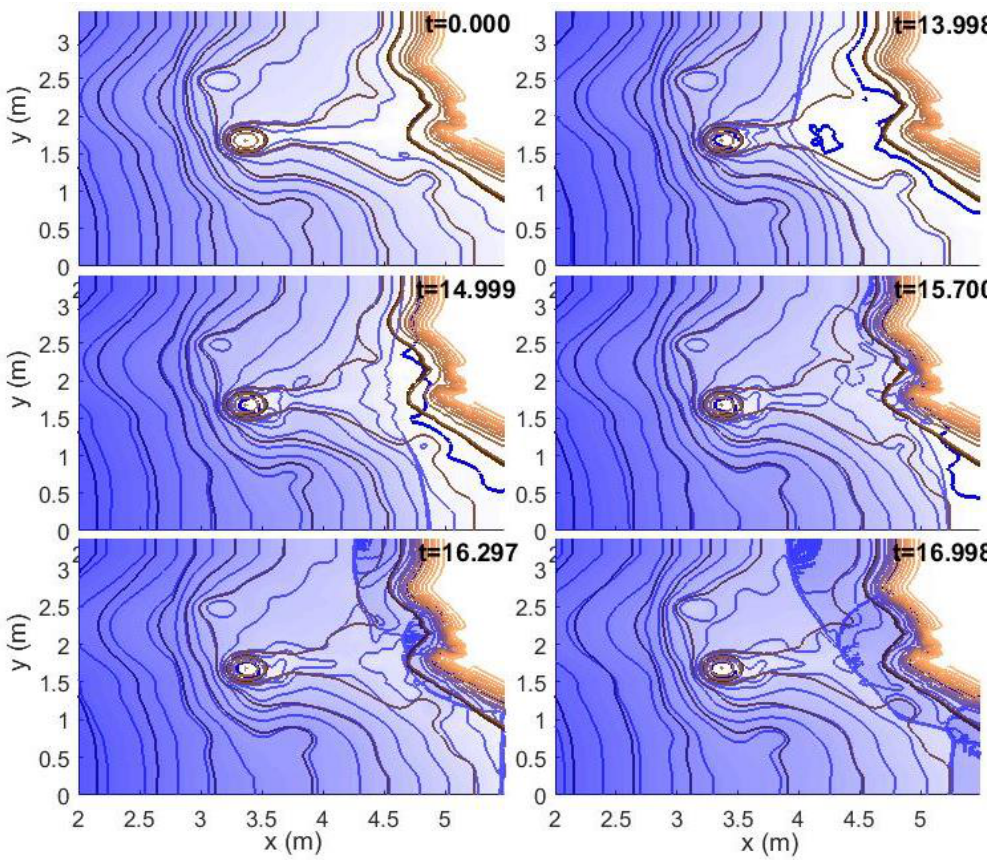
Figure 12. Shoreline at t = 0 s, 14 s, 15 s, 15,7 s, 16,3 s, 17 s. The contour of water level (blue line), shoreline (bold blue line), beach (brown line), and initial shoreline (bold brown line).